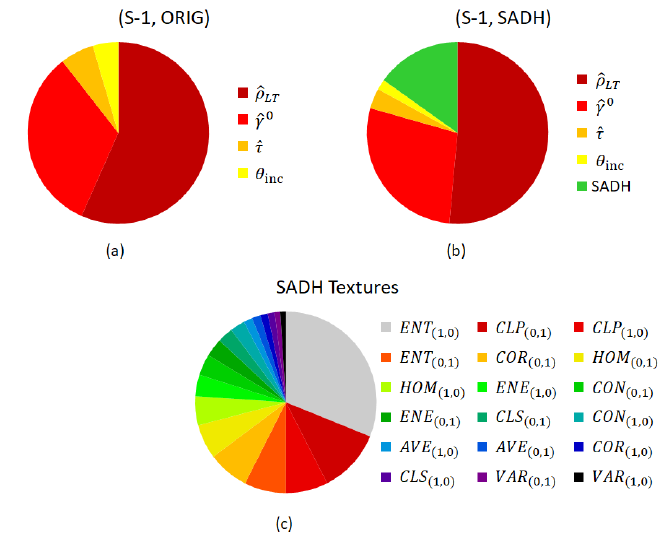
Figure 8. Feature importance for the two analyzed cases, ( a ) ORIG and ( b ) SADH; in particular, pie chart ( c ) shows the distribution of importance for the SADH textures